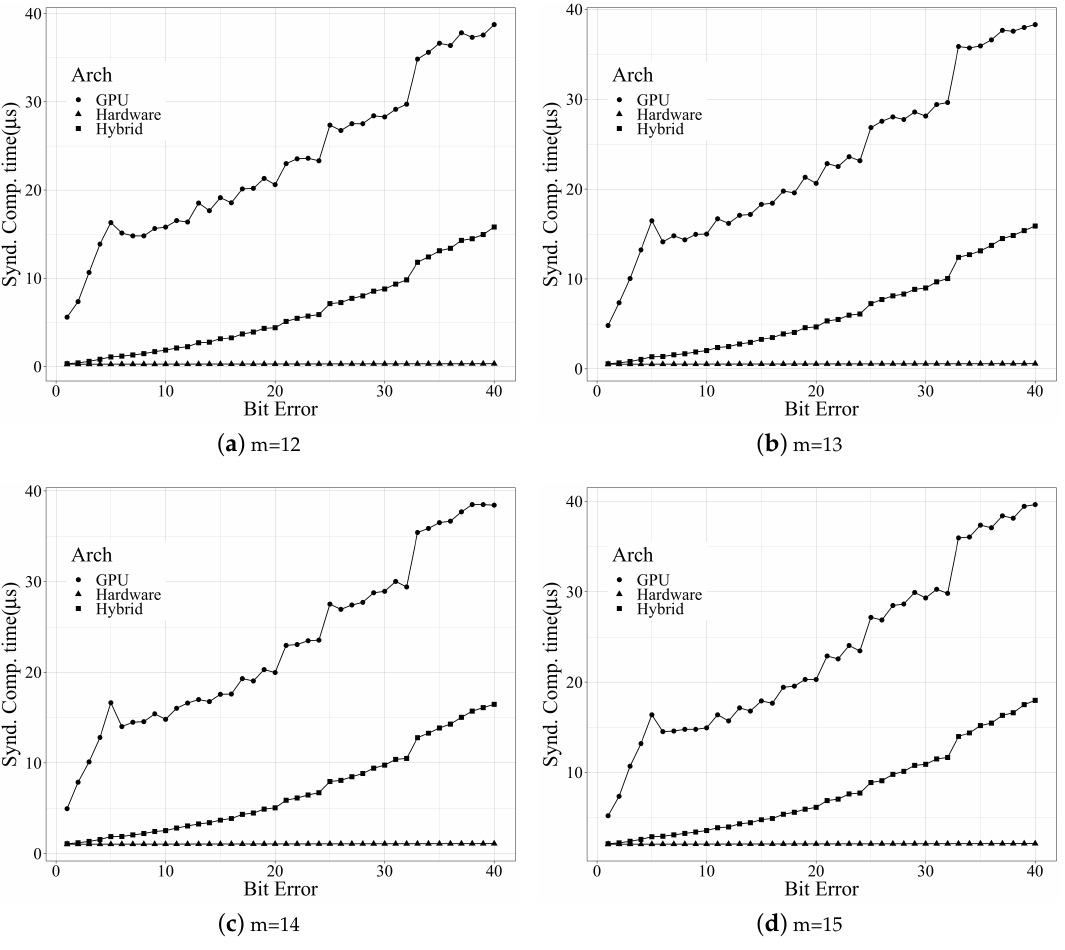
Figure 7. Syndrome computation time for different